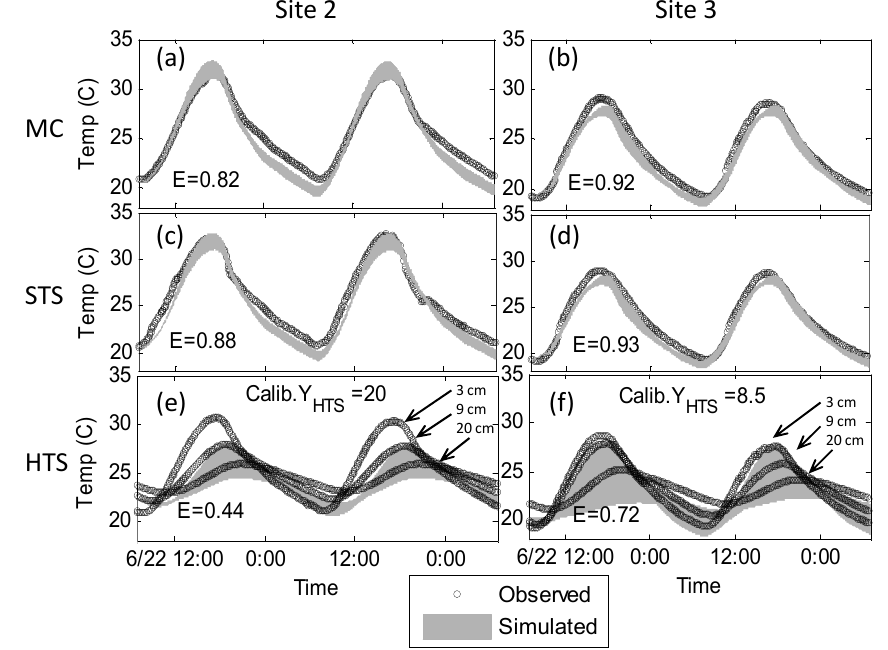
Fig. 8. Test 9 (Level 4) plots of temperature data for Site 2 and Site 3 in the main channel MC (a, b) , STS (c, d) , and HTS (e, f) , where the observations at three depths are labeled (3, 9 and 20cm). E , the performance at each location, is shown in each subplot.